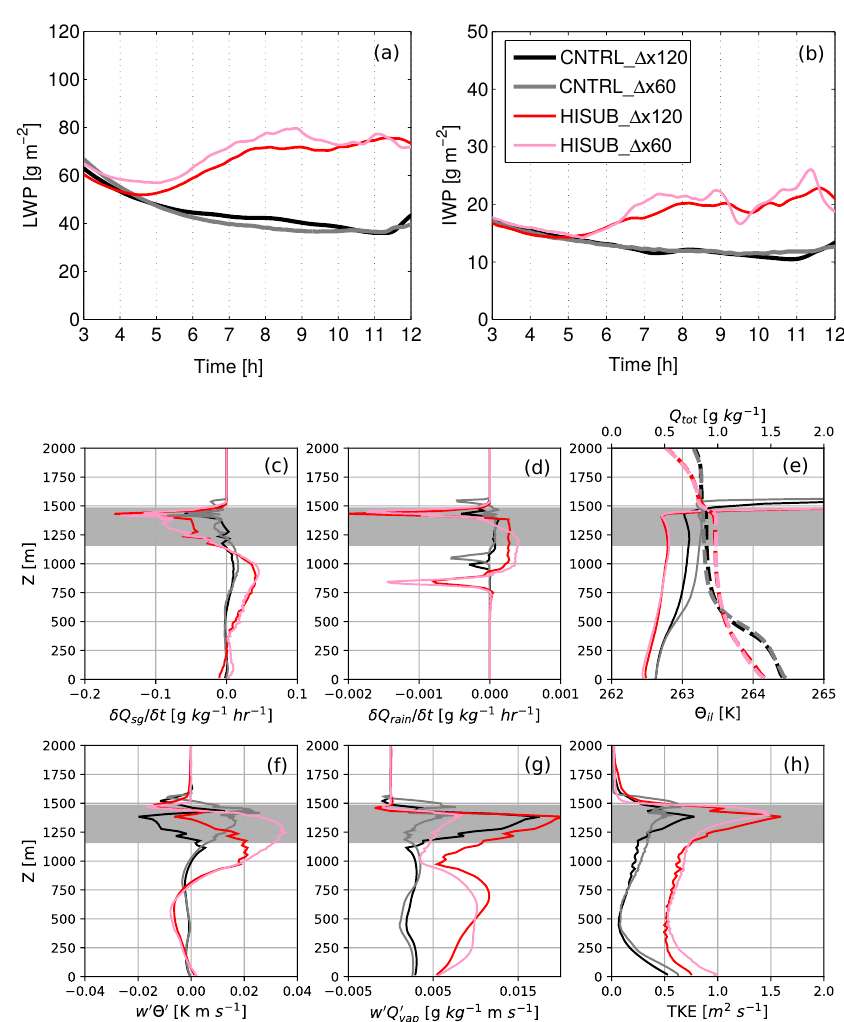
Figure 13. Influence of domain resolution on changing imposed large-scale subsidence. Only the CNTRL and HISUB cases are consid- ered. LWP (a) and IWP (b) time series for simulations with 120m resolution (default configuration) and 60m resolution (high-resolution configuration). Black: CNTRL, default; grey: CNTRL, high resolution; red: HISUB, default; and pink: HISUB, high resolution. (c–h) Verti- cal profiles (at 9h) of (c) solid precipitation (snow + graupel) mass tendency ( δQ sg /δt ), (d) rain mass tendency ( δQ rain /δt ), (e) ice–liquid potential temperature ( (cid:50) il , solid) and total water mixing ratio ( Q tot , dashed), (f) buoyancy flux ( w (cid:48) (cid:50) (cid:48) ), (g) vertical flux of water vapour ( w (cid:48) Q (cid:48) vap ), and (h) total turbulent kinetic energy (TKE). Fluxes shown are total quantities (sub-grid + advected). Area in grey represents CNTRL_ (cid:49) x120m cloudy